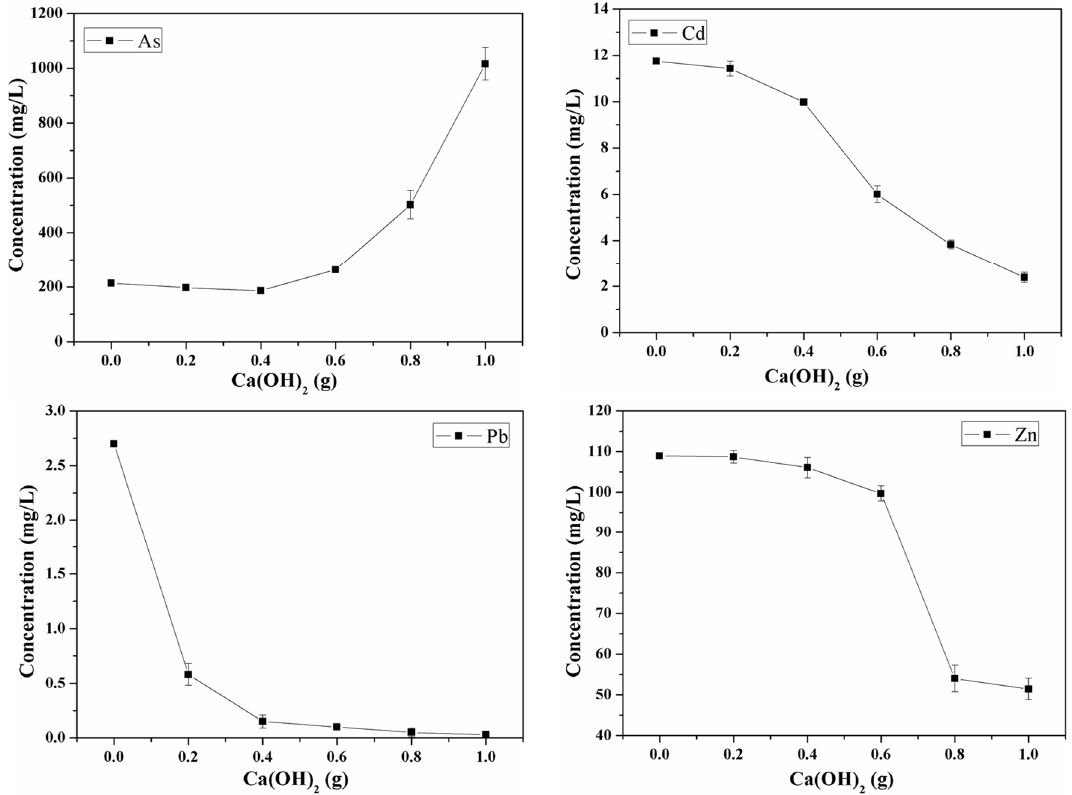
Figure 8. Effect of Ca(OH) 2 addition on the release concentrations of heavy metals.